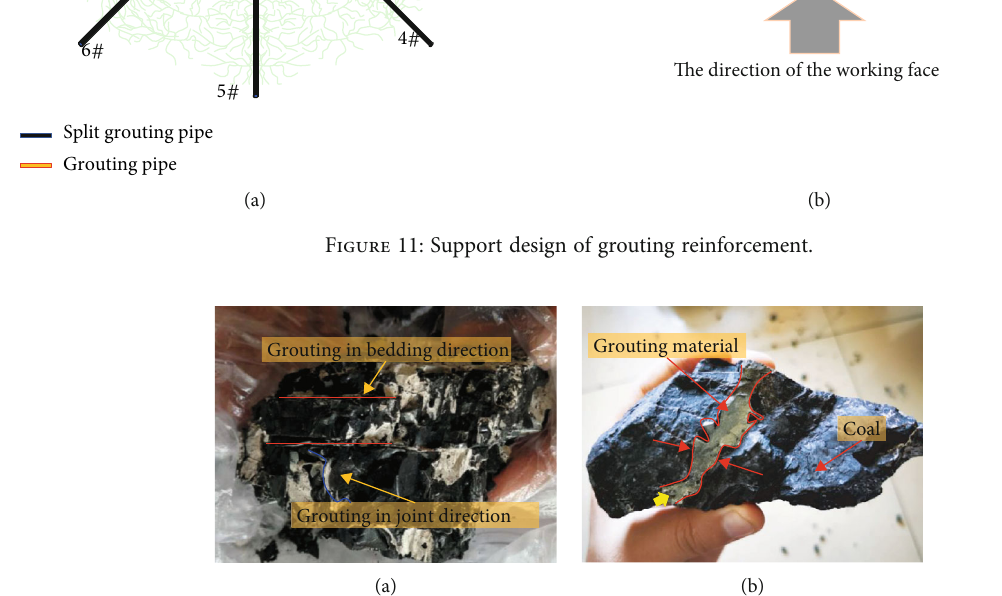
Figure 12: Sample of the grouting block. (a) Sample of the shallow coal. (b) Sample of the deep